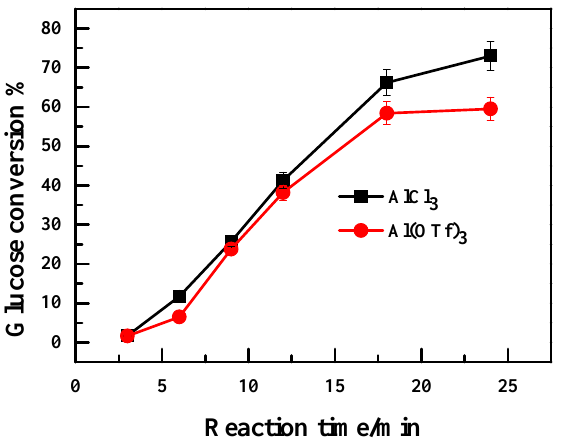
Figure 5. Effect of the anion style of Lewis acid salts on the conversion of glucose. Reaction conditions: reaction temperature of 160 °C, reaction time of 25 min, 0.1 g glucose in 1.5 g 25 mM Lewis acids aqueous solution, 3 g sec-butyl phenol.